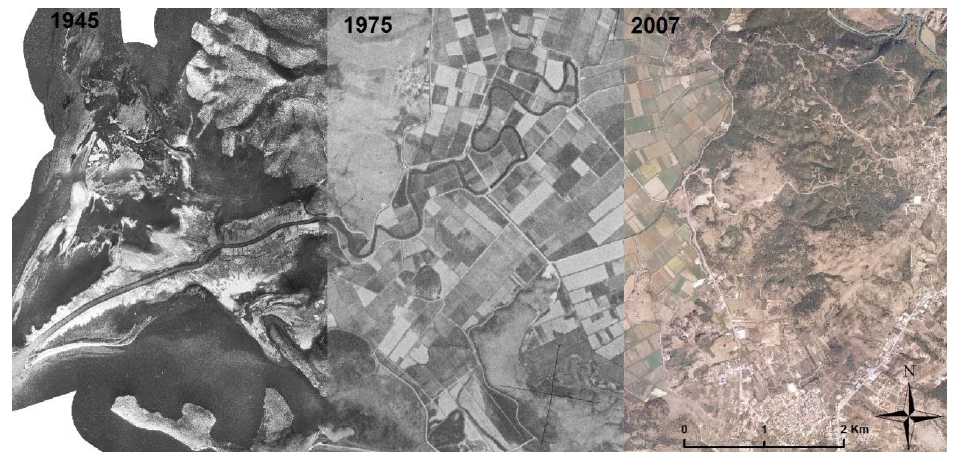
Figure 3. Series of aerial photographs (1945, 1975, 2007) used for the creation of thematic land use / land cover (LULC) maps and spatial matching following their geometric correction and adjustment. A section of Kalamas Delta is shown here as an example.